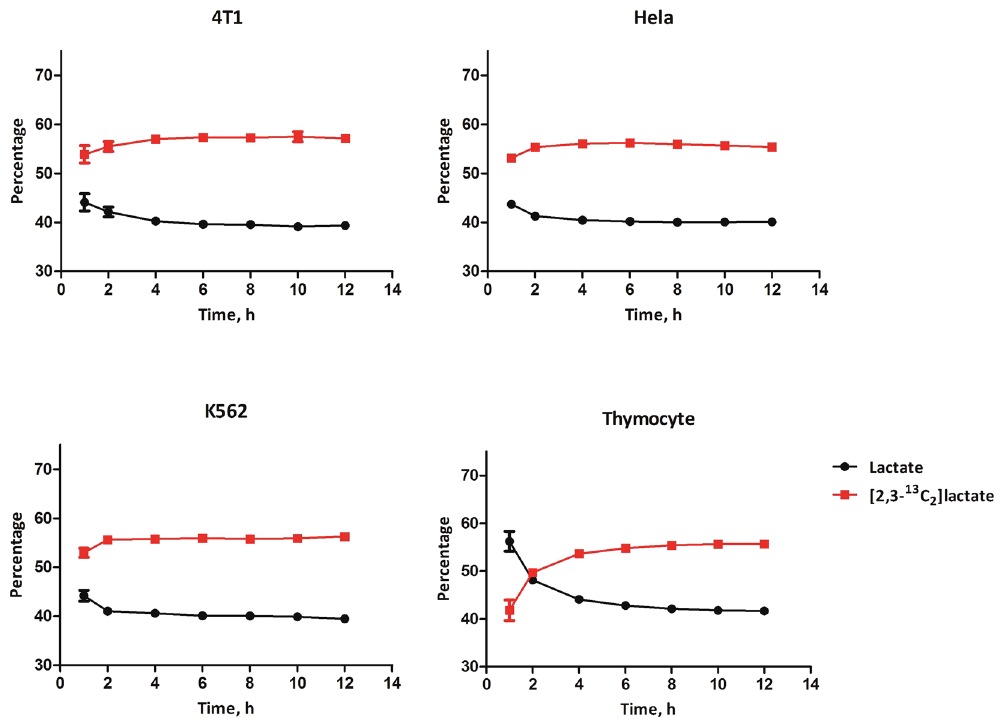
Figure 1. A time course of generation of [2,3- 13 C 2 ]lactate (from glucose carbon 1, 2, 3) and lactate (from glucose carbon 4, 5, 6) (n = 12) from 4T1, Hela, K562 and thymocyte. Cells were incubated in serum free RPMI- 1640 containing 6 mM [1,2- 13 C 2 ]glucose and supernatant was collected for LC-MS analysis as described in Materials and Methods. Data were mean ± SD, n = 12, from 2 independent experiments.